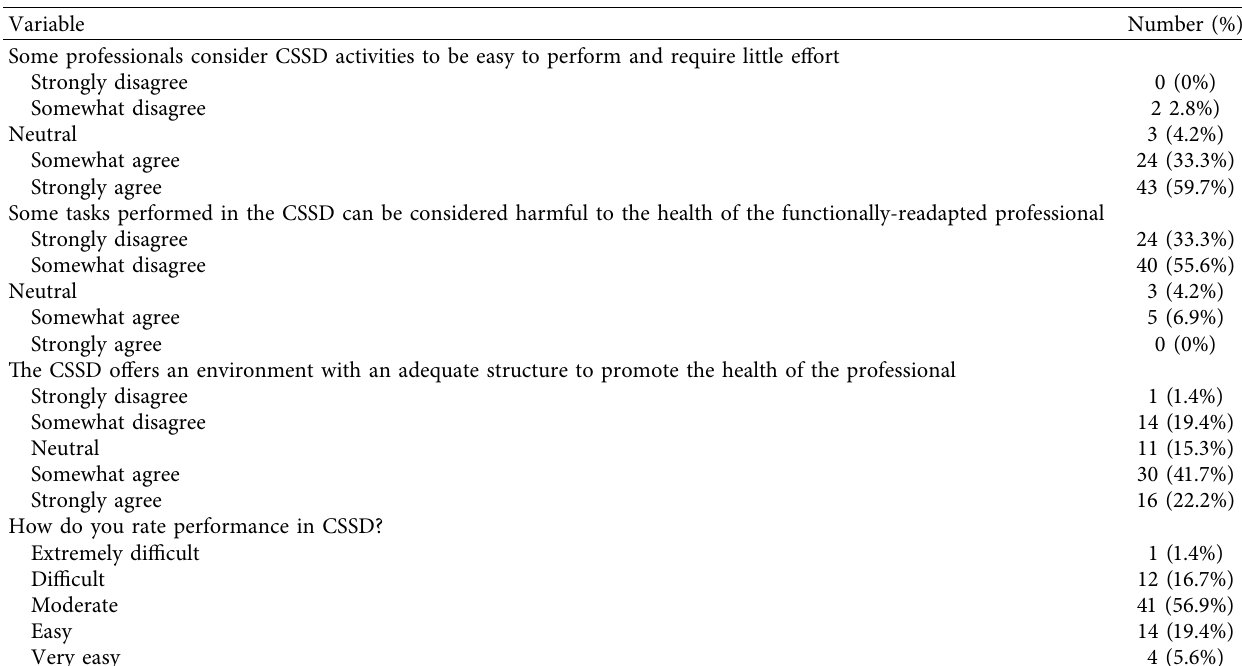
Figure 1: Decreasing distribution of comorbidities in the evaluated sample. WMSD: work-related musculoskeletal disorders. RSI: repetitive strain injuries. Table 3: Distribution of participants’ opinions regarding health risk, professional skills, and work environment in the central sterile supply